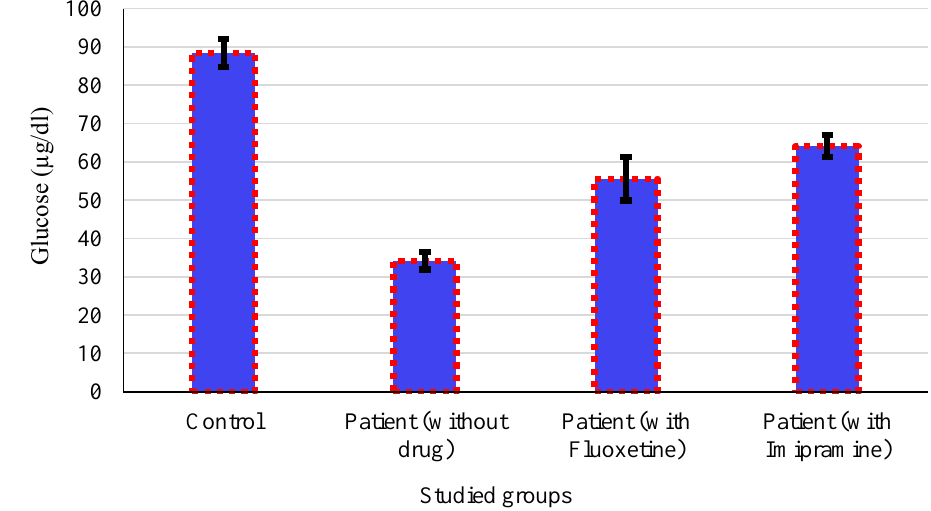
Fig. 7. Comparison of the glucose between studied